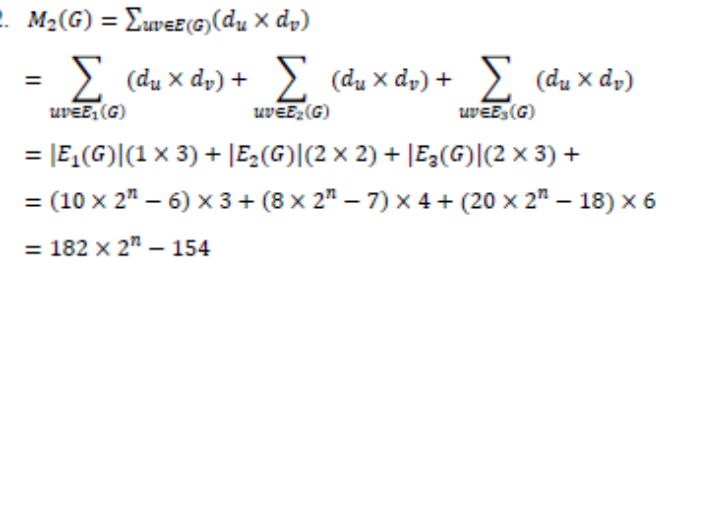
Figure 2: Molecular structure of dendrimer based on glycerol and succinic acid (Wolinsky et al .,